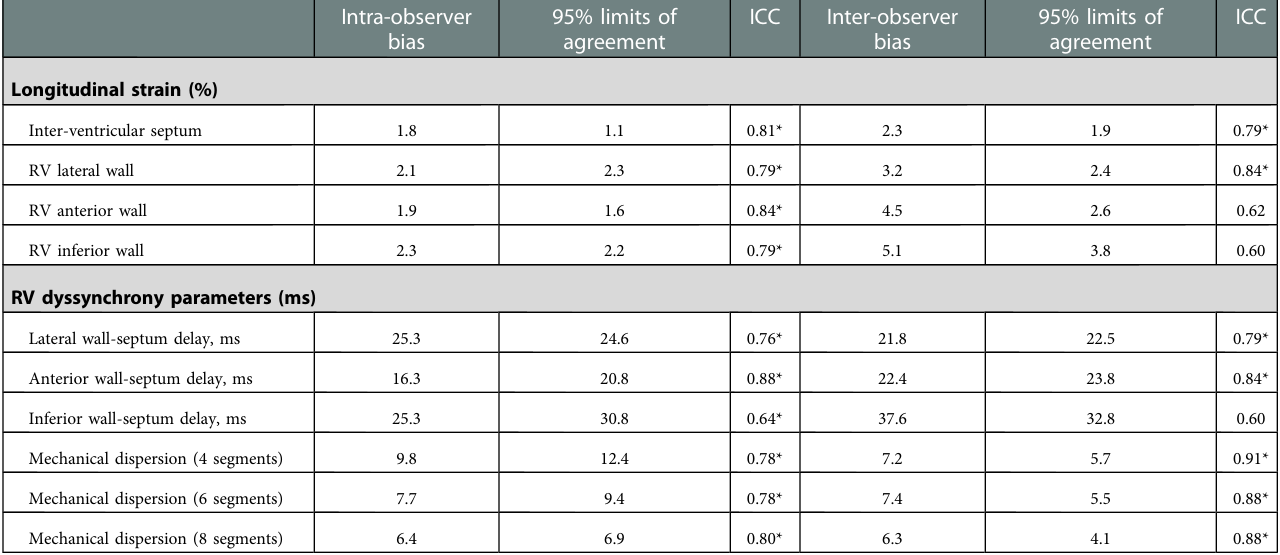
TABLE 5 Intra- and inter-observer agreements of multi-RV wall strain and electromechanical dyssynchrony